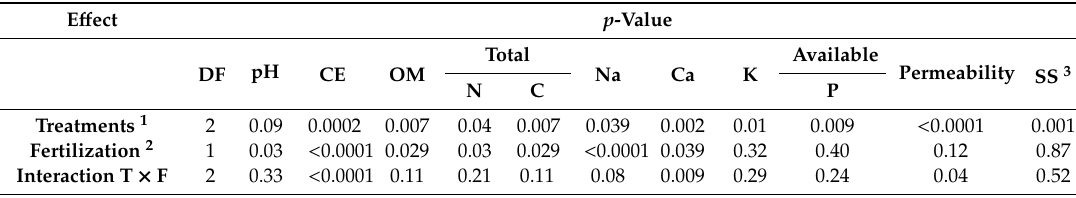
Table 3. Analysis of variance (ANOVA) of the e ff ects of the addition of deinking paper sludge on physical and chemical calcaric soil properties after two annual DPS applications. 1 Treatments: control,